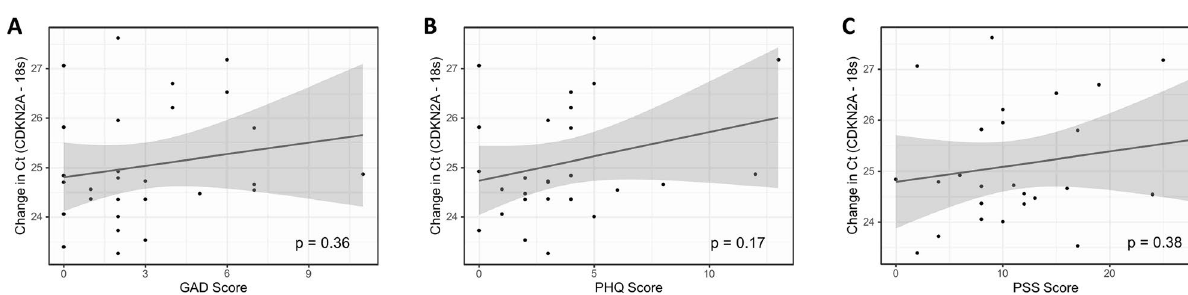
Figure 3. Correlation of senescence markers with psychosocial stress